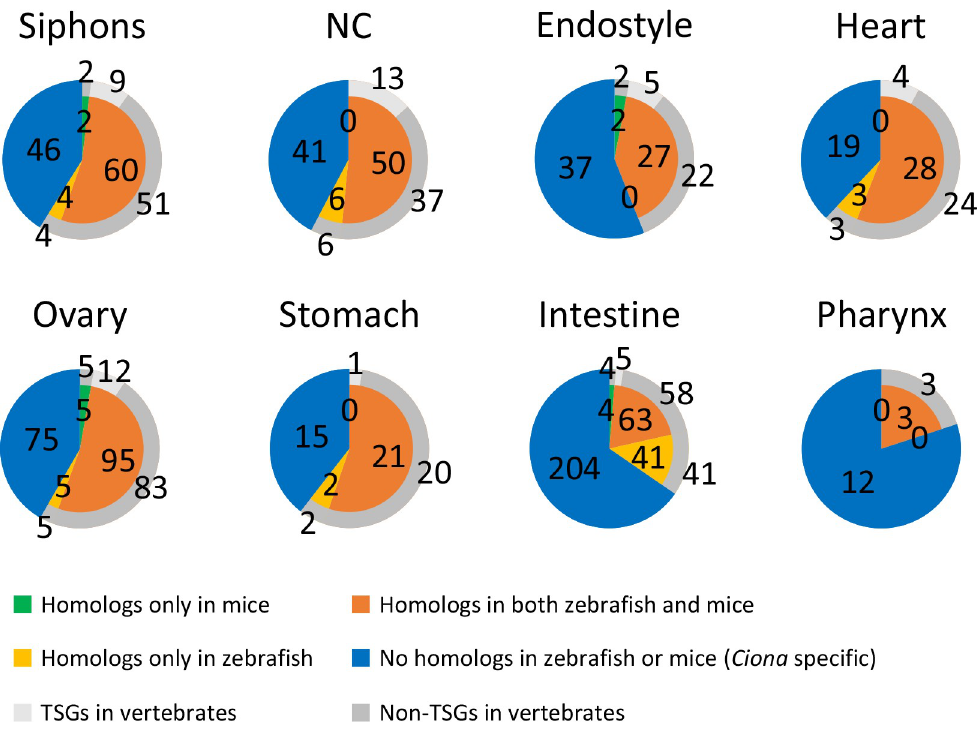
Fig 2. Number of genes homologous to the Ciona TSGs in mice and zebrafish. Amino acid sequences of the Ciona TSGs were blasted against the RefSeq protein database of mice and zebrafish with the e-value set to < 1e-5. The number of genes homologous to mice (green), zebrafish (yellow), or both (orange) in each tissue are shown. The genes without BLAST hits are shown as non-homologous (blue). Among the vertebrate homologs, TSGs and non-TSGs in the vertebrate tissues were also investigated using RNA-seq data of mice (PRJNA267840) and zebrafish (PRJNA255848), and shown in light grey and dark grey, respectively. NC, neural complex.